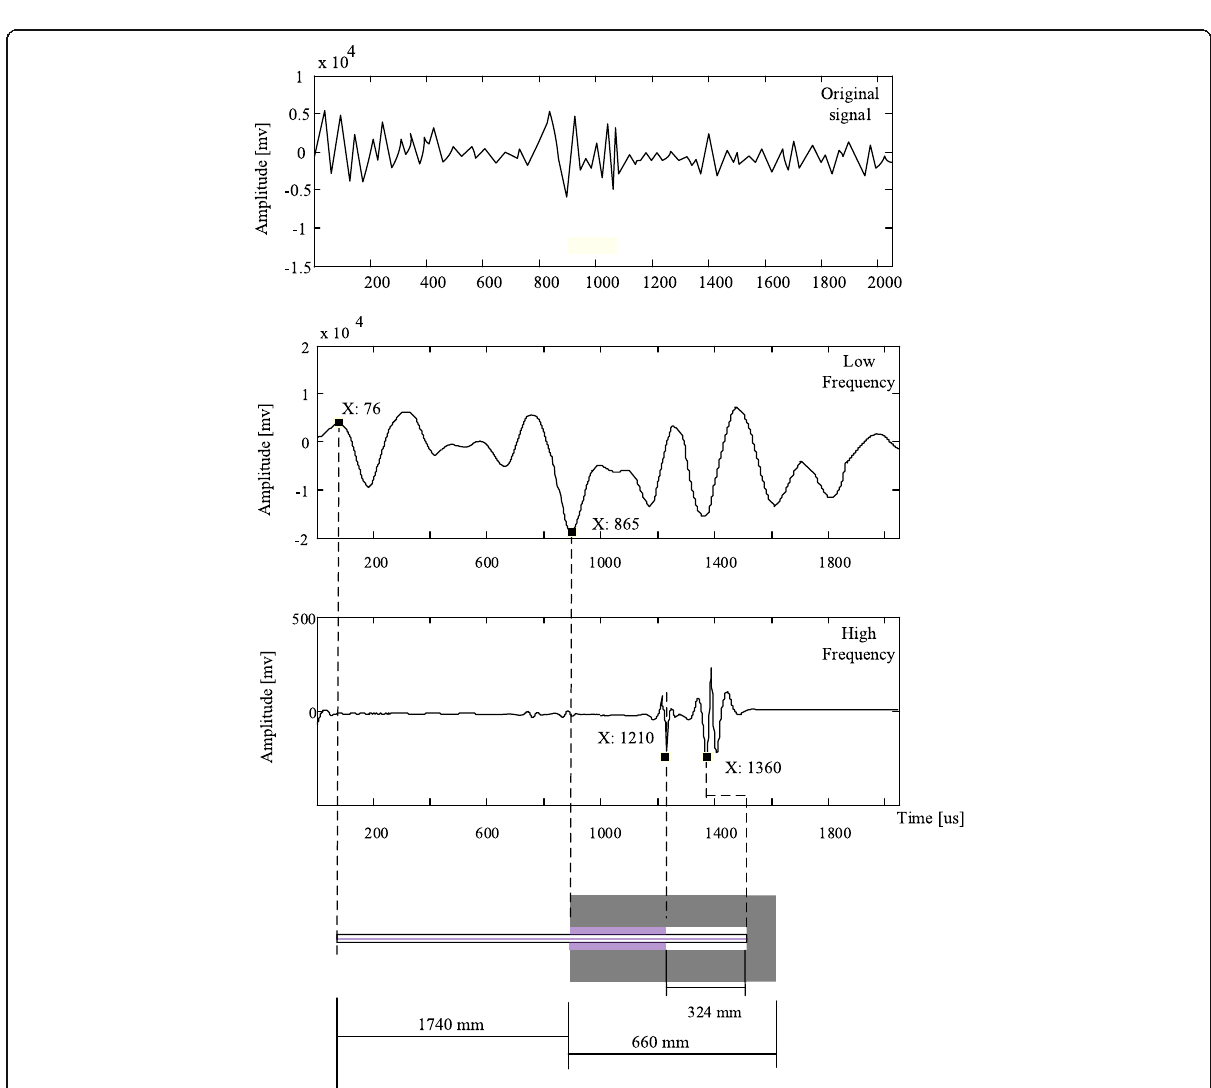
Fig. 10 High-frequency waveform of sample 6# (unit: mm)